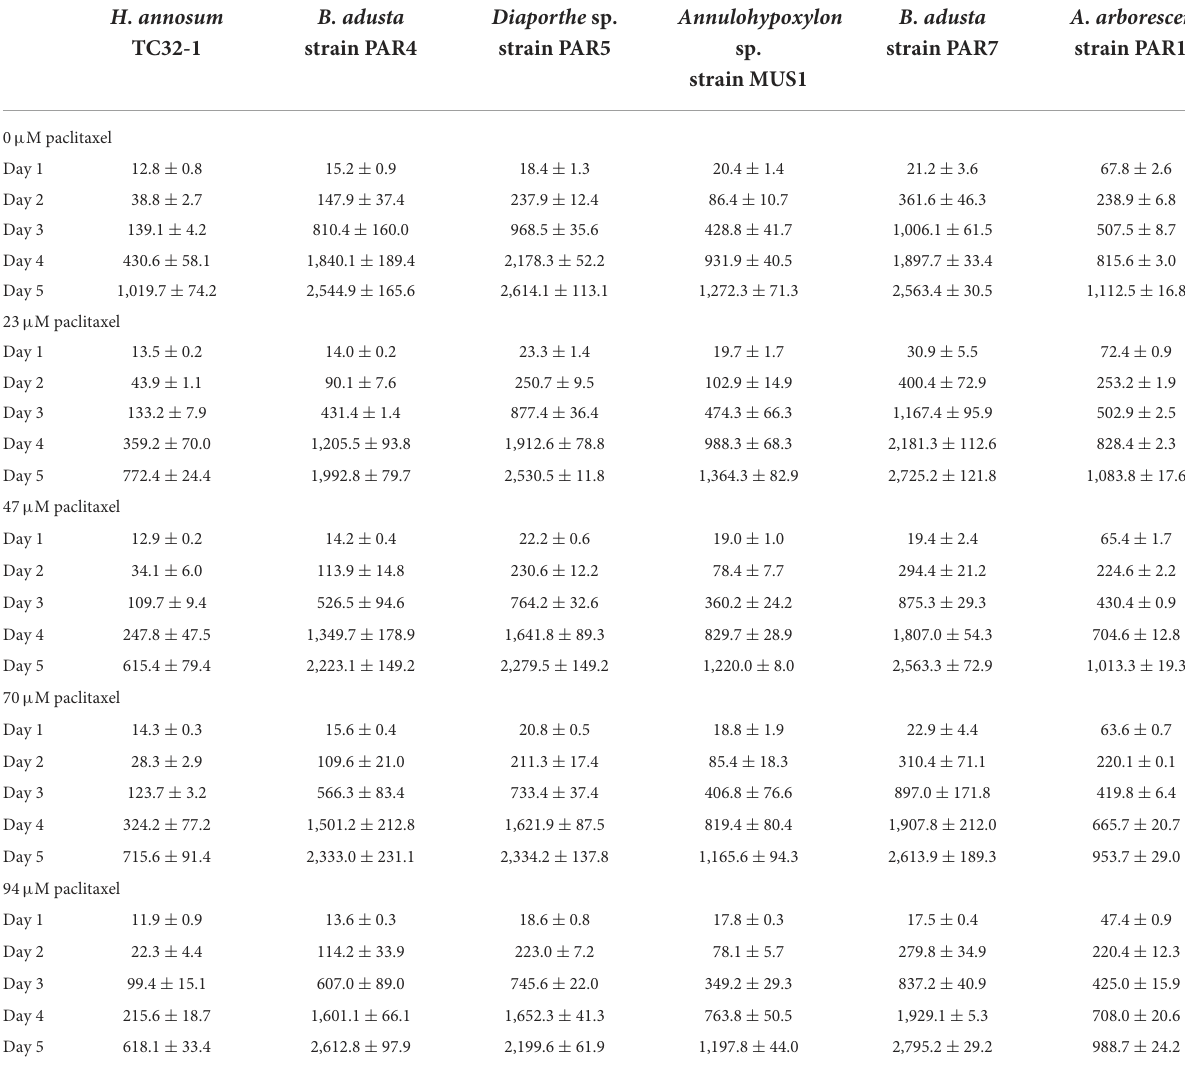
TABLE 2 Comparison of growth area for the fungi grown in PDA media at increasing concentrations of